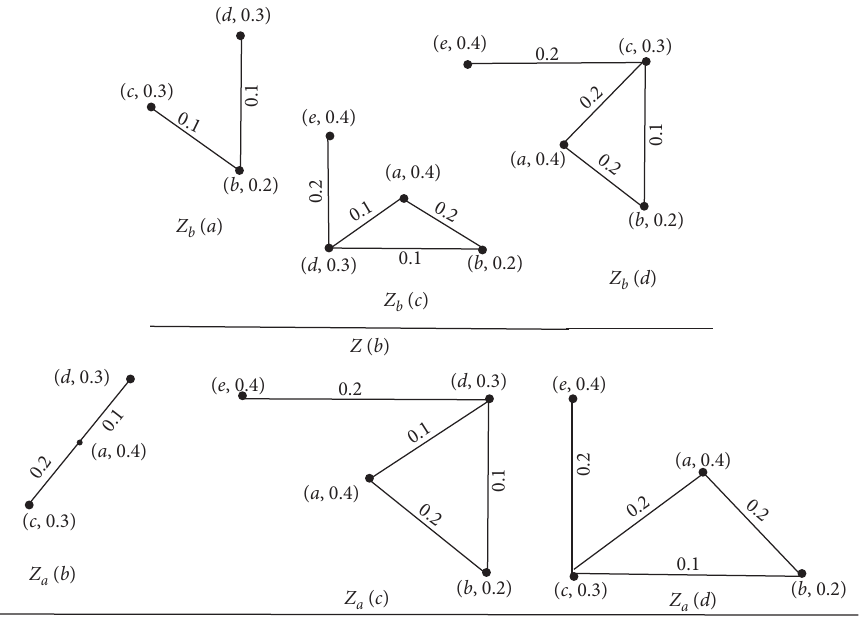
Figure 14: G � ( Z ( b ) , Z ( a ))